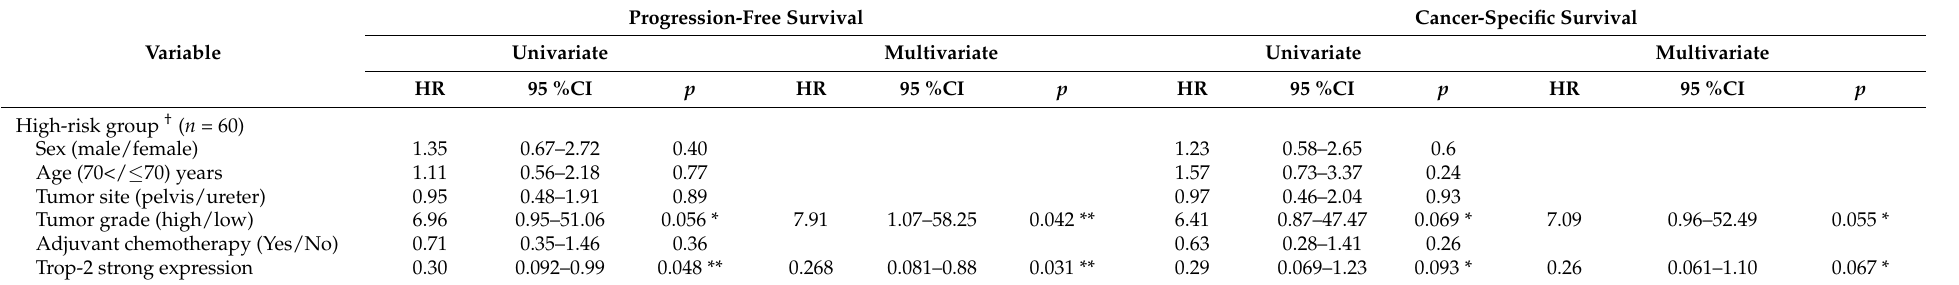
Table 4. Univariate and multivariate analyses of progression-free survival and cancer-specific survival in patients with high-risk upper tract urothelial carcinoma. Progression-Free Survival Cancer-Specific